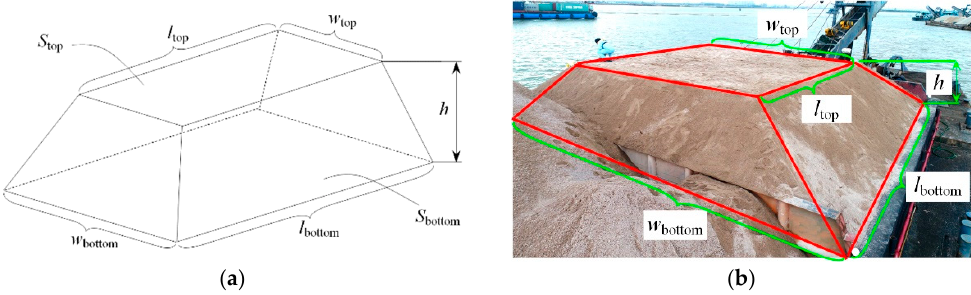
Figure 3. Stockpile with a regular trapezoid: ( a ) model of a stockpile with a regular trapezoid above